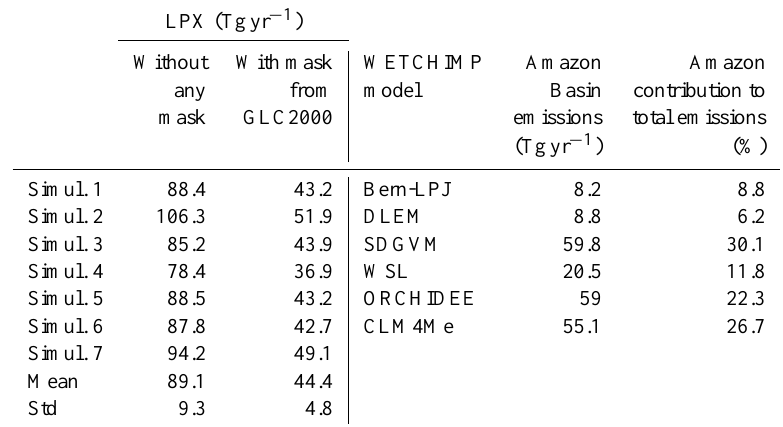
Table 7. LPX-simulated floodplain CH 4 emissions at Amazon Basin scale (averaged over 1993–2004) and comparison to the WETCHIMP models. The used Bern-LPJ estimates do not account for wet mineral soils (see Wania et al., 2013). LPX estimates are given with (left) and without (right) filtering using GLC2000 (see Sect.